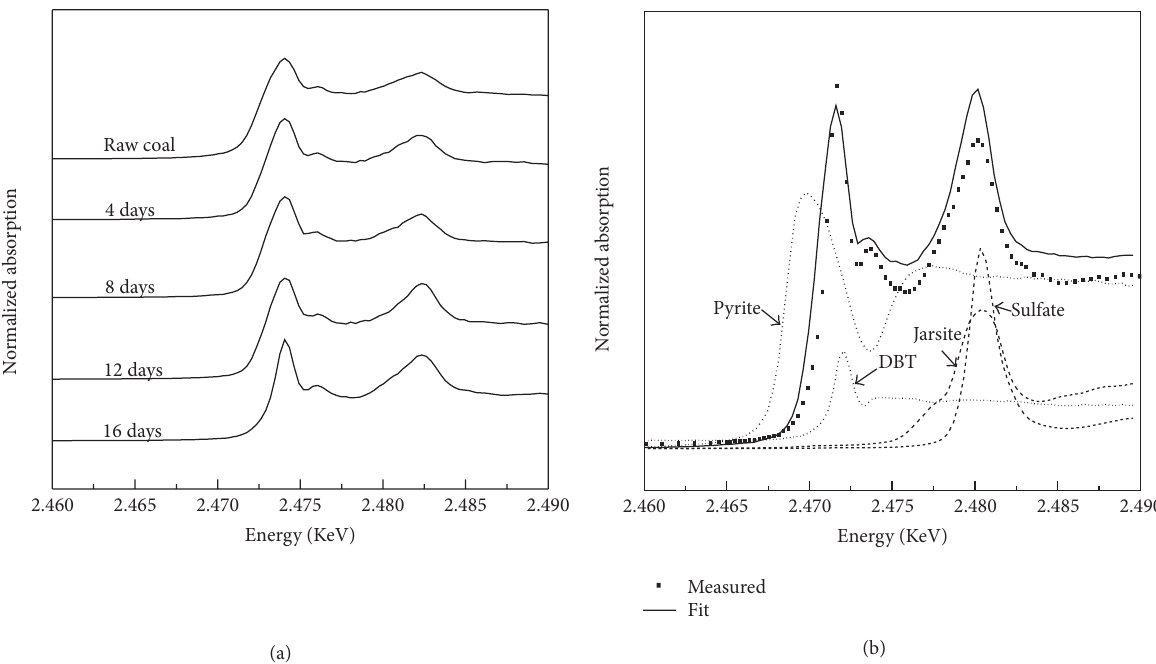
Figure 5: Normalized sulfur K-edge XANES spectra of coal samples processed with A. ferrooxidans.